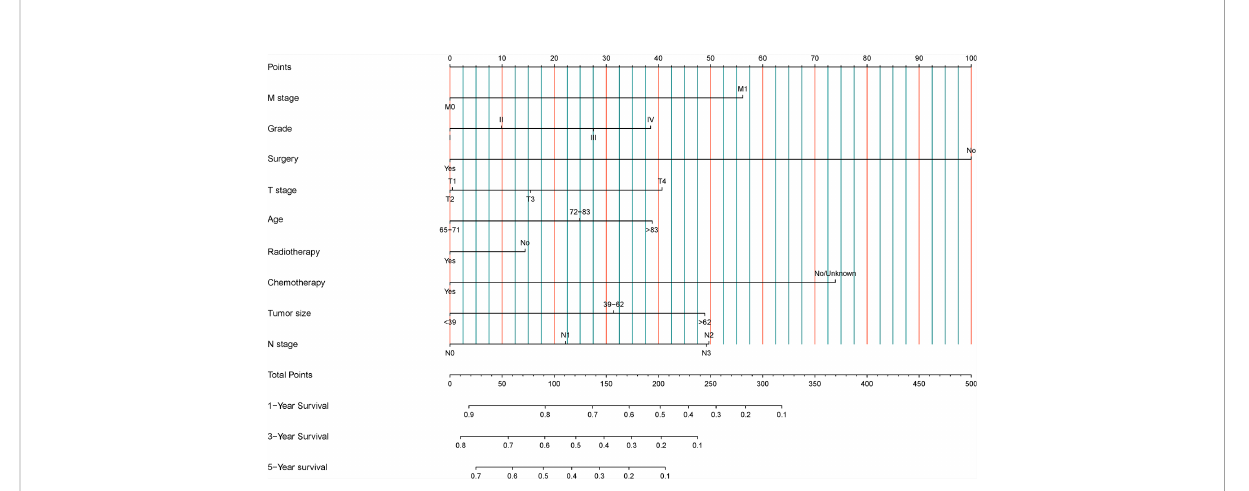
FIGURE 2 Development of a prognostic strati fi cation nomogram and validation of the proposed